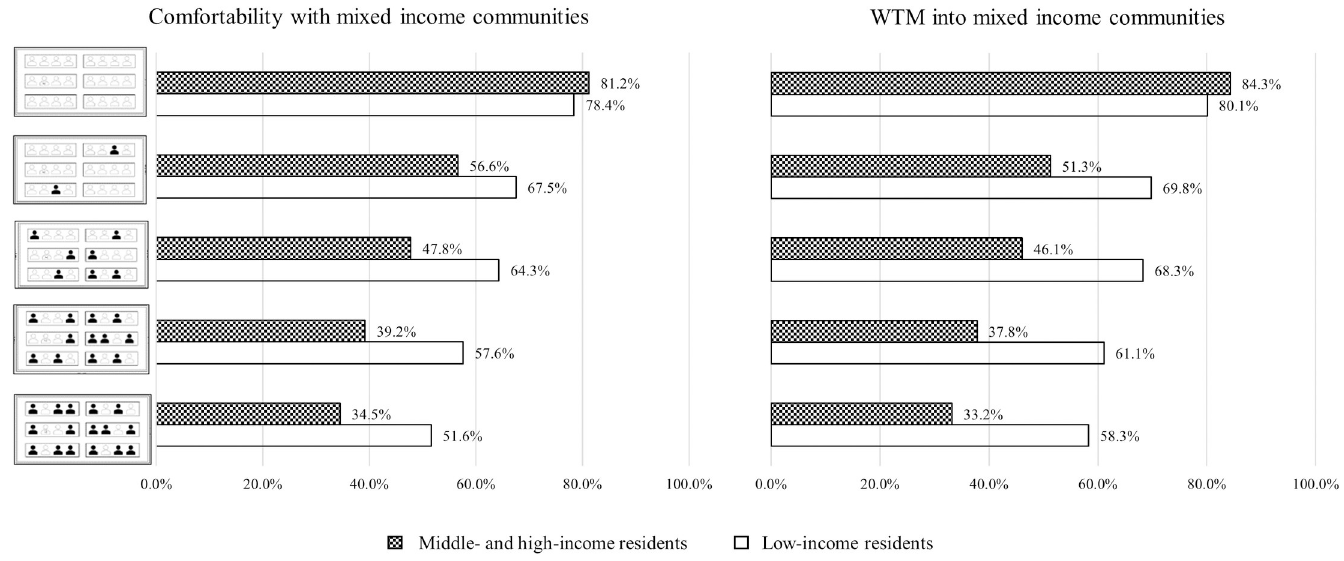
Fig 2. Comfortability with and WTM into mixed-income